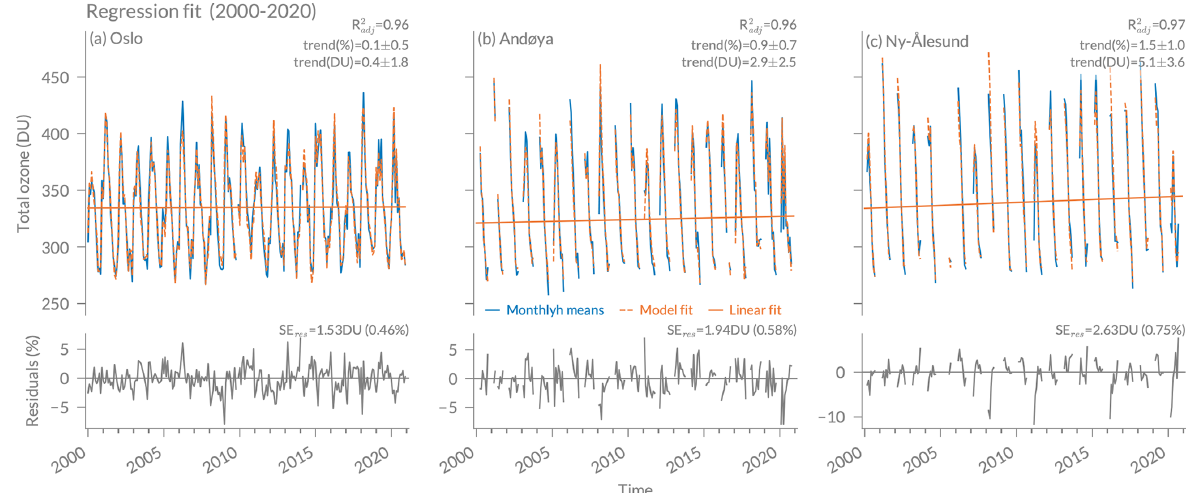
Figure 7. Regression fit of total ozone for (a) Oslo, (b) Andøya, and (c) Ny-Ålesund. The resulting linear trend is given in percent per decade and DU per decade with 2-standard-deviation ( σ ) uncertainties. The lower panels show the residuals of the regression fit in percent ((Data − Model) / Data) and the standard error of the residuals (SE res ) in DU and percent (compared to the mean ozone value at each station).